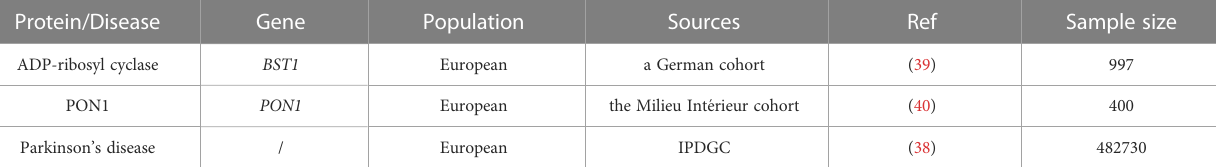
TABLE 1 Summary of genome-wide association study (GWAS) datasets for MR analysis.